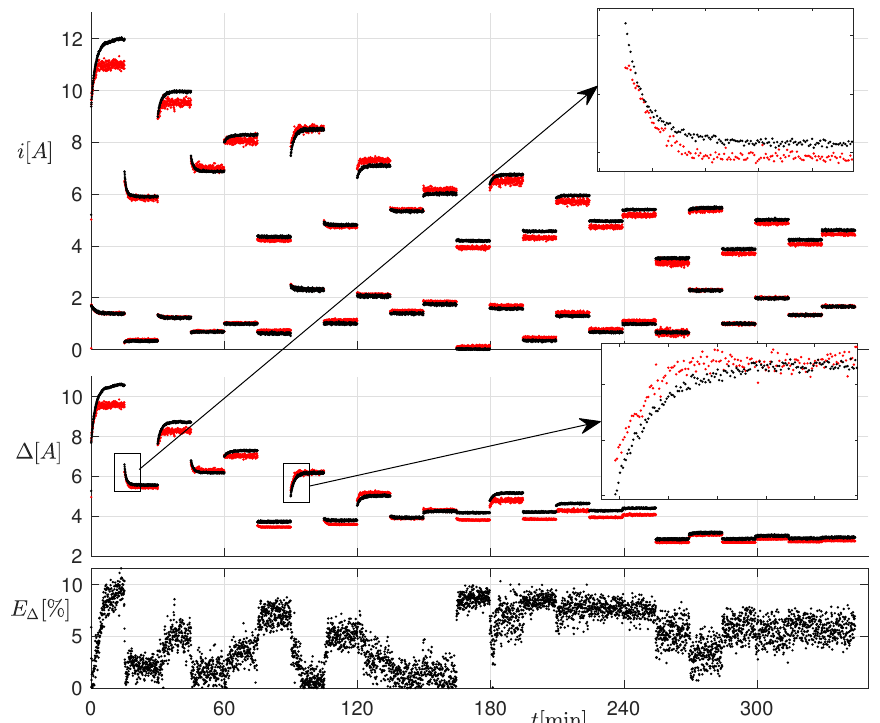
Figure 12. Top panel: measured (black) and estimated (red) current at electrical steady-state for all the considered operating conditions. Middle panel: measured (black) and estimated (red) current ripple. Bottom panel: relative percent error on the current